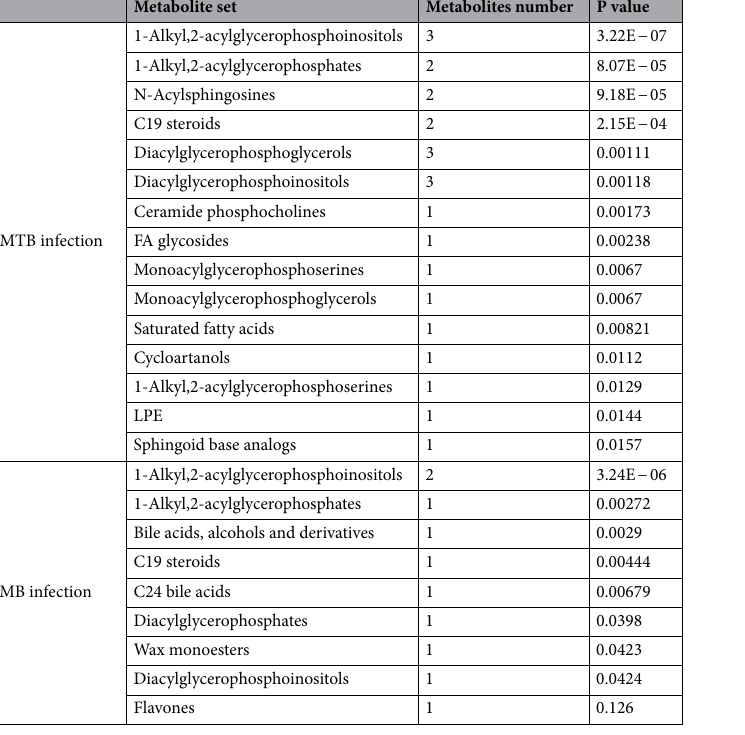
Table 2. Lipid sub-classification of MTB- or MB